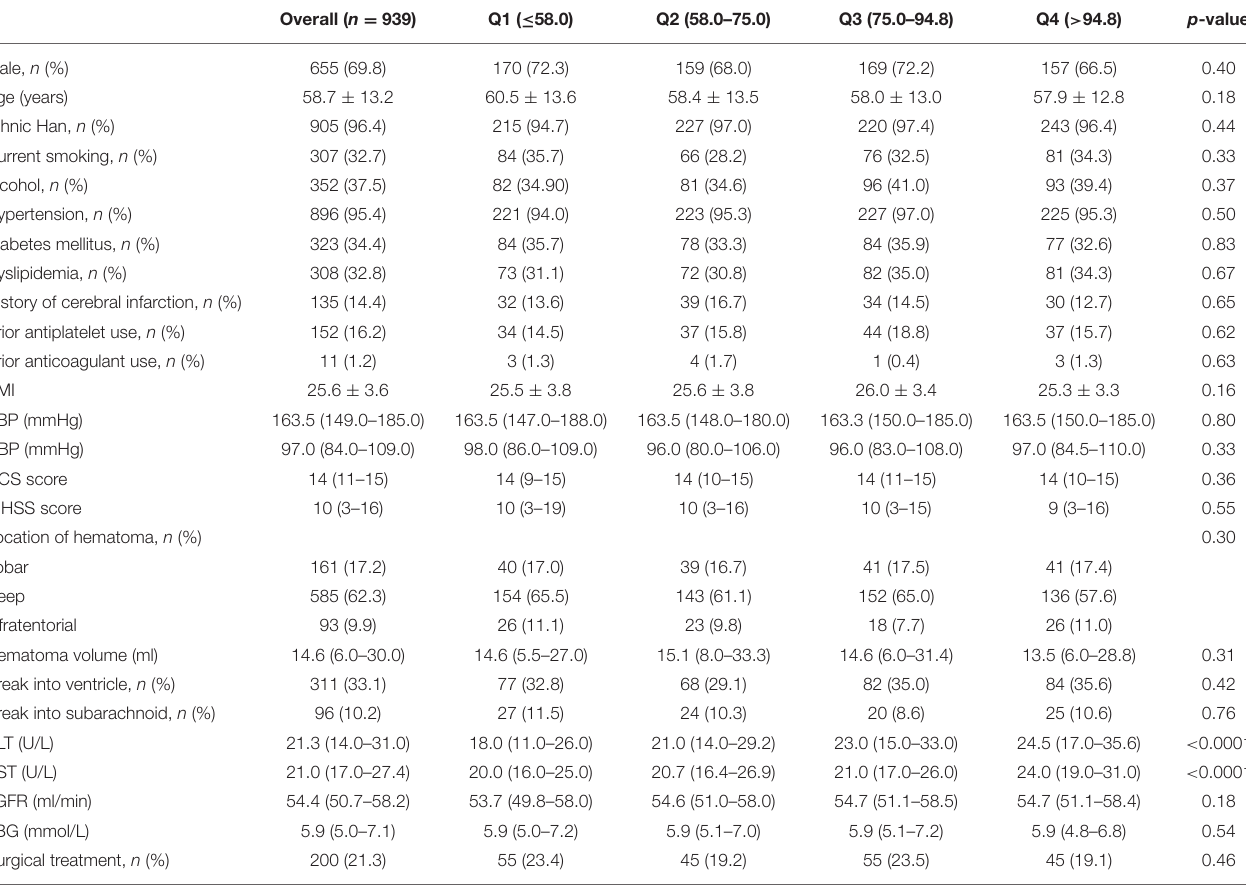
TABLE 1 | Baseline characteristics of the participants according to the quartiles of ALP